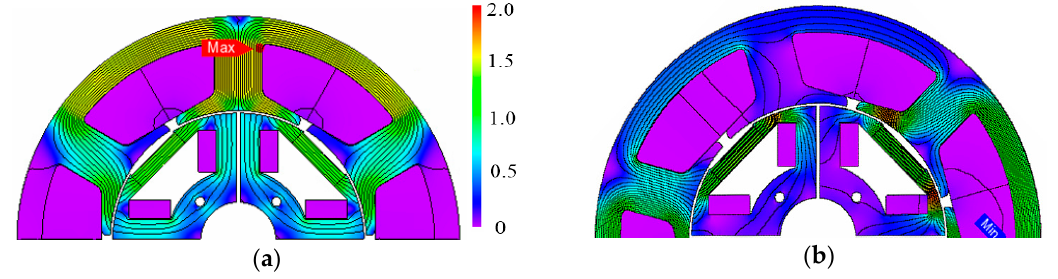
Figure 4. Flux distribution for proposed structure. ( a ) d -axis; ( b ) q -axis.